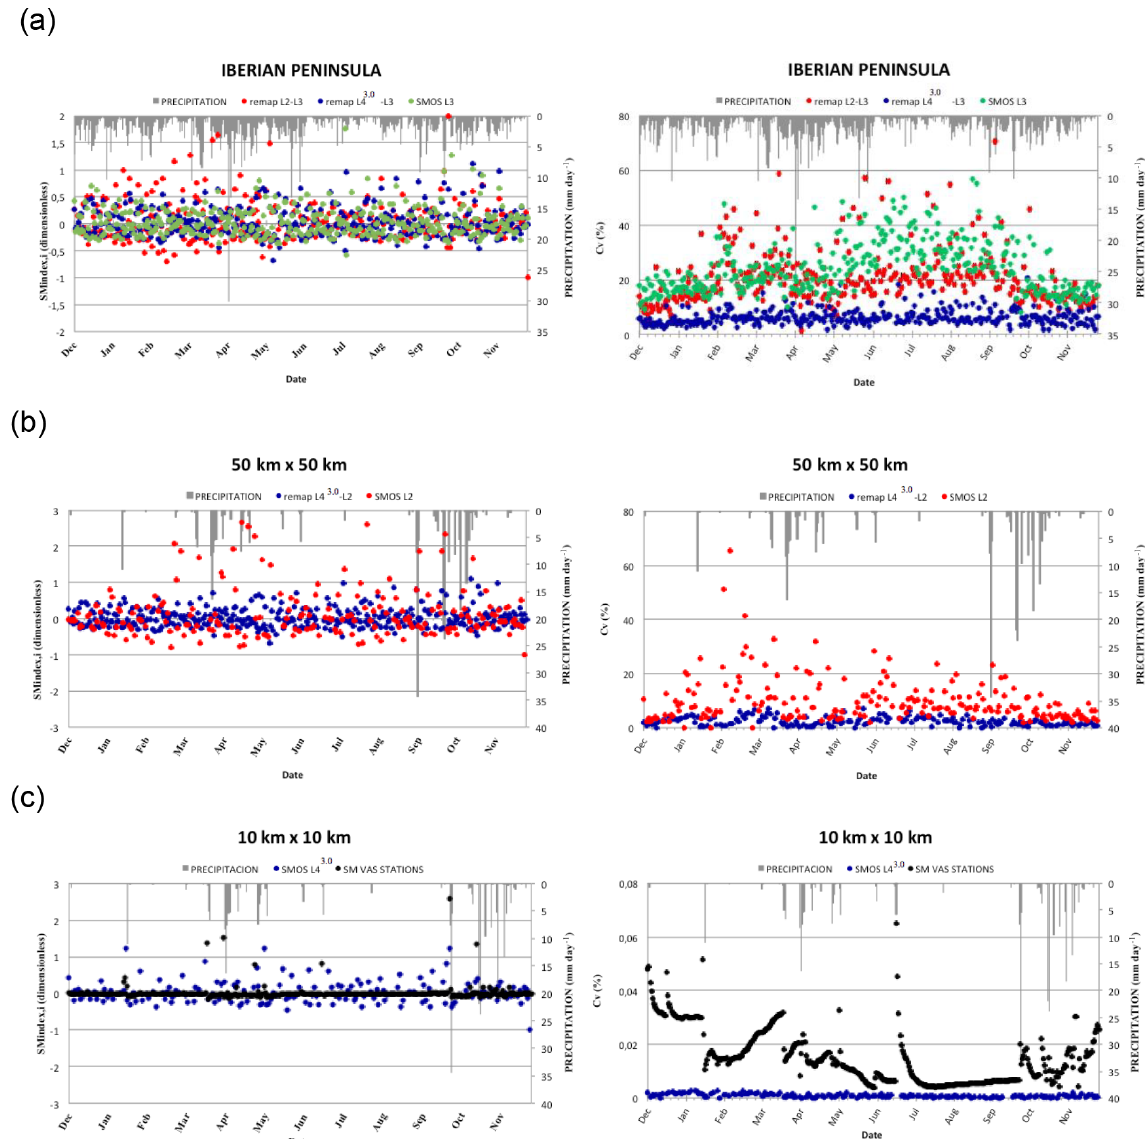
Figure 5. Averaged SMOS products and averaged ground-based observations of soil moisture evolution over the Iberian Peninsula (IP; a ), the VAS area (b) and the OBS area (c) . Descending orbits are used. Precipitation from AEMET rain gauges are shown at the top of each plot. The soil moisture daily index (O v index ,i ; dimensionless) is shown in the left-hand plots, and the coefficient of variation (Cv, %) is shown in the right-hand